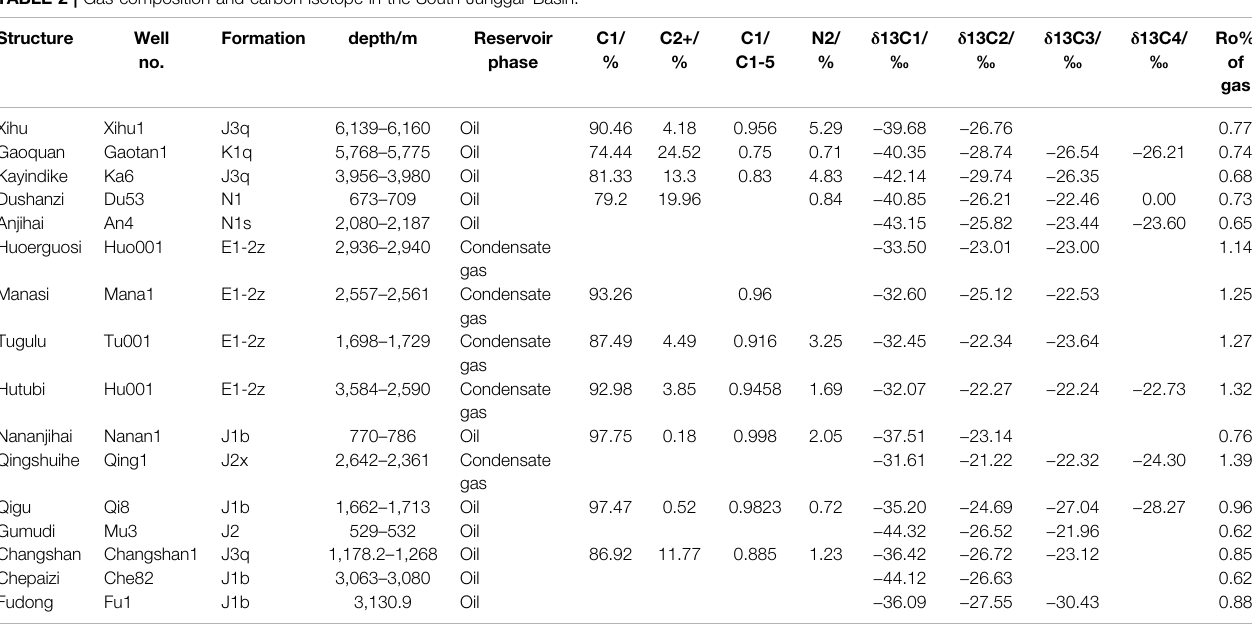
TABLE 2 | Gas composition and carbon isotope in the South Junggar Basin. Structure Well